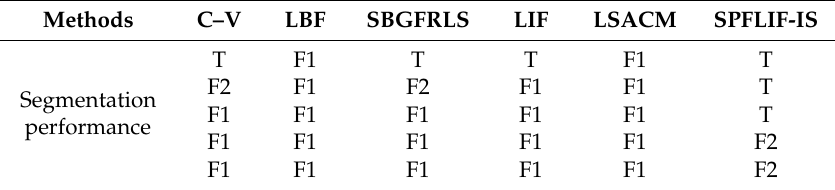
Table 3. Description of the segmentation results of Figure